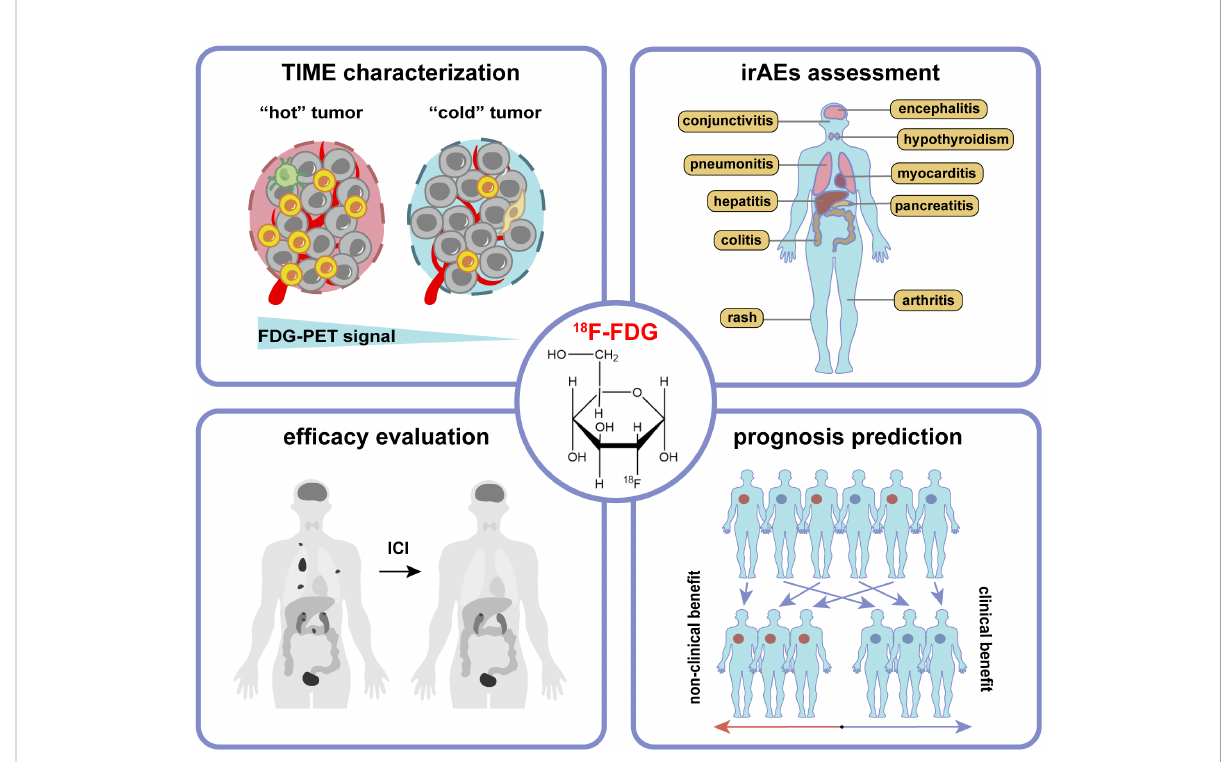
FIGURE 2 The application of 18 F-FDG PET/CT imaging in tumor immunotherapy includes characterization of tumor immune microenvironment (TIME), assessment of immune-related adverse events (irAEs), evaluation of therapeutic ef fi cacy, and prediction of